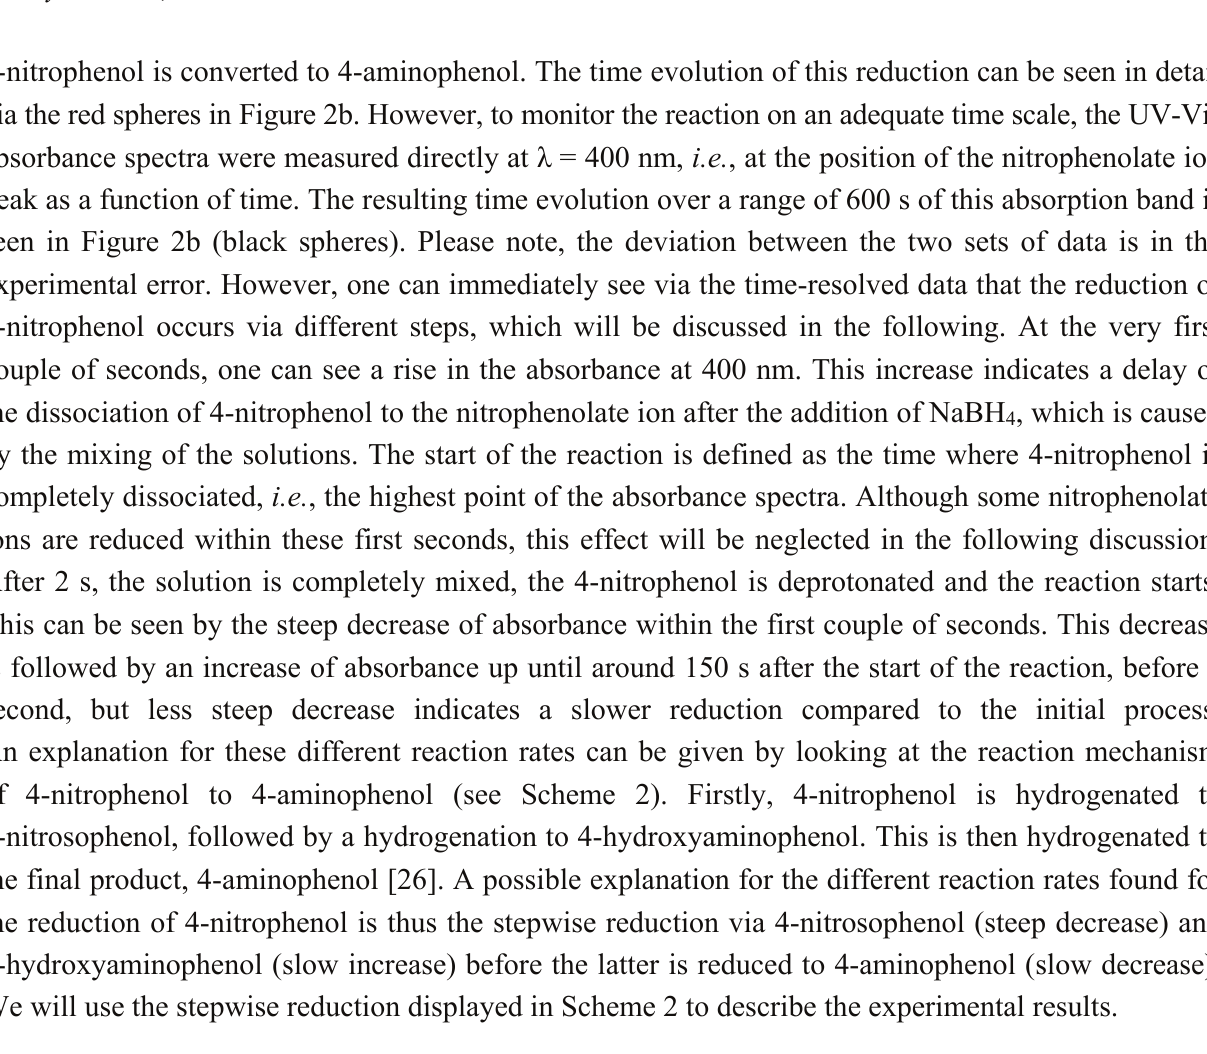
Figure 2. ( a ) The UV-Vis absorbance spectrum of the reduction of 4-nitrophenol to 4-aminophenol via PtPb nanoparticles as the catalyst; ( b ) The UV-Vis absorbance spectrum for the reduction of 4-nitrophenol over 600 s (black spheres), monitored at 400 nm. The red spheres show the absorbance of the measurement from the spectrum displayed in ( a ). Both reductions were performed at 23 °C with 1 mg of catalyst ( i.e. , 0.3 mg PtPb NPs and concentration of c = 6.196 mM and an initial 0.7 mg polymer), an initial NaBH 4 NABH4 4-nitrophenol concentration of c = 0.0317 Nip